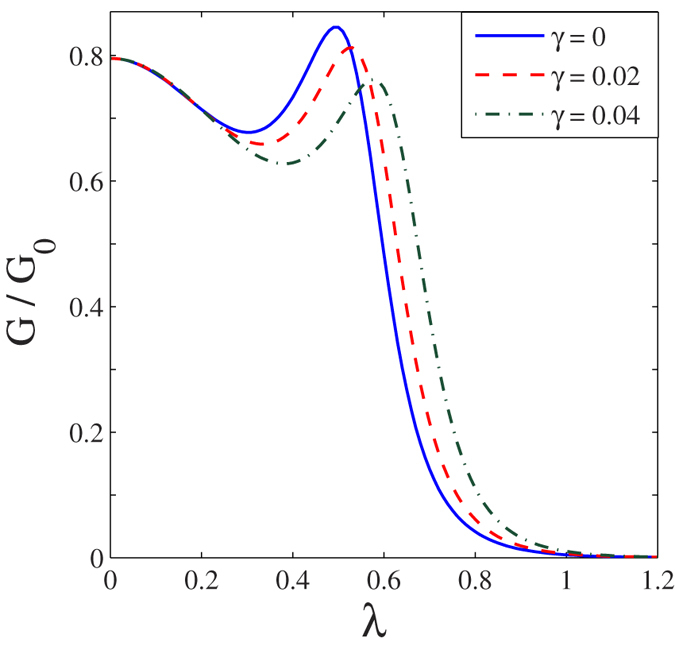
G/G0 as a function of λ for a few values of γ with eVB = 0.6.